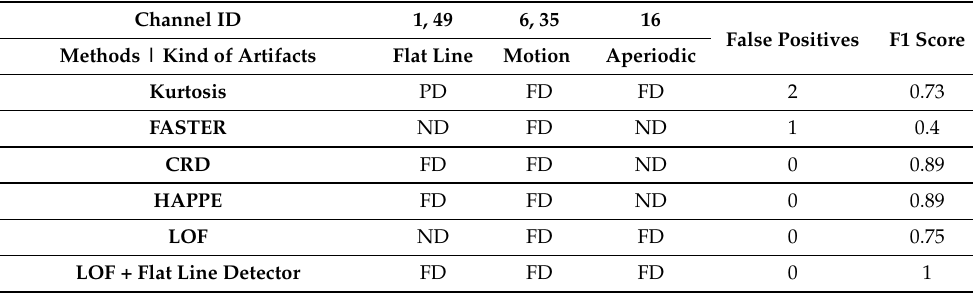
Table 1. Summary of results on simulated EEG with 64 channels. ND = Not Detected; PD = Partially Detected; FD = Fully